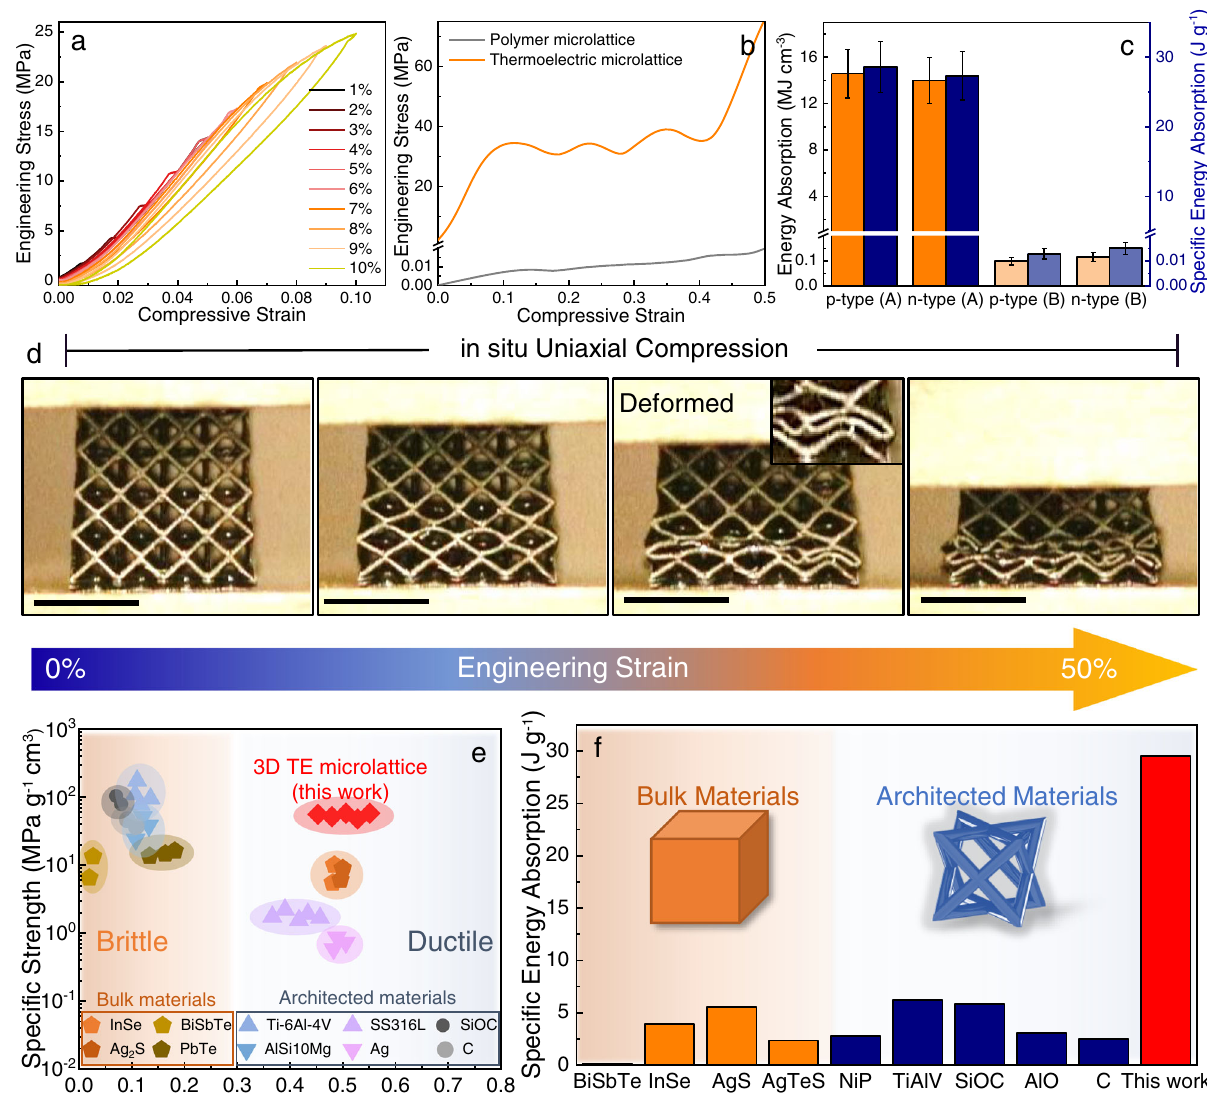
Fig. 3 | In situ mechanical characterization of thermoelectric microlattices. a Loading-unloading compression curves of the thermoelectric microlattice showing the near-fully elastic behavior at strains higher than most of previously reported brittle TEGs and microlattices. b Stress – strain curves from uniaxial compression of the thermoelectric microlattices and polymer microlattices, showingthedrasticincreaseinmechanicalstrength(>2ordersofmagnitude)ofthe polymer microlattice upon partial carbonization and coating with thermoelectric fi lm. c Energyabsorptioncapabilitiesofthedevelopedthermoelectricmicrolattices compared to the commercially obtained monolithic TEG legs under uniaxial compression. Data are presented as mean while the error bar represents the stan- dard deviation. d Deformation behavior of the thermoelectric microlattices under uniaxial compression, demonstrating its exceptional ductility with negligible strut